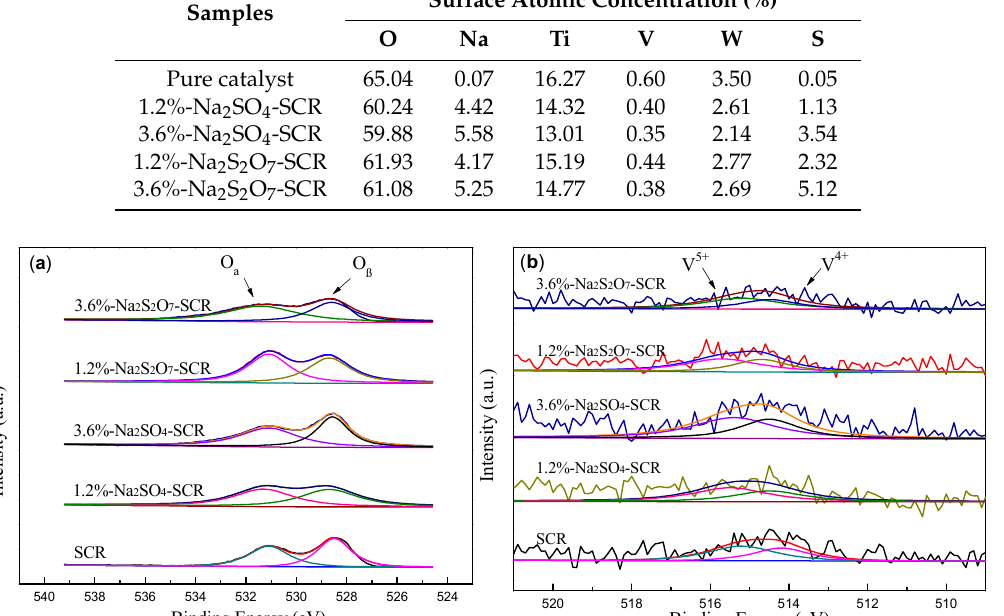
Figure 9. X-ray photoelectron spectroscopy (XPS) spectra for ( a ) O 1S and ( b ) V 2P over these samples.